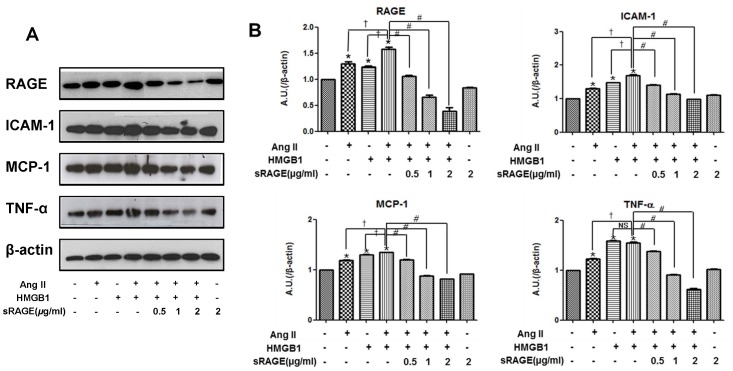
Effect of sRAGE in Rat Aorta Vascular Smooth Muscle Cells.Western blot analysis showing expression of A, RAGE inflammation receptor protein, ICAM-1, MCP-1, and TNF-α; and B, Quantitative data from panel A. Expression of RAGE, ICAM-1, MCP-1, TNF-α, and β-actin were detected by western blot. Lane 1, control; lane 2, AngII-treated for 24 hours (100 nM); lane 3, HMGB1 treated for 15 minutes (1 µg/ml); lane 4, AngII plus HMGB1; lane 5, AngII plus HMGB1 and sRAGE (0.5 µg/ml); lane 6, AngII plus HMGB1 and sRAGE (1 µg/ml); lane 7, AngII plus HMGB1 and sRAGE (2 µg/ml); lane 8, treatment with sRAGE alone at 2 µg/ml. The optical density is expressed in arbitrary units normalized against a control. Data in histograms represent mean ± SD from 3 experiments. *p<0.01 vs control, †
p<0.01 vs lane 4, #
p<0.01 vs lane 4, ns = non-significant.